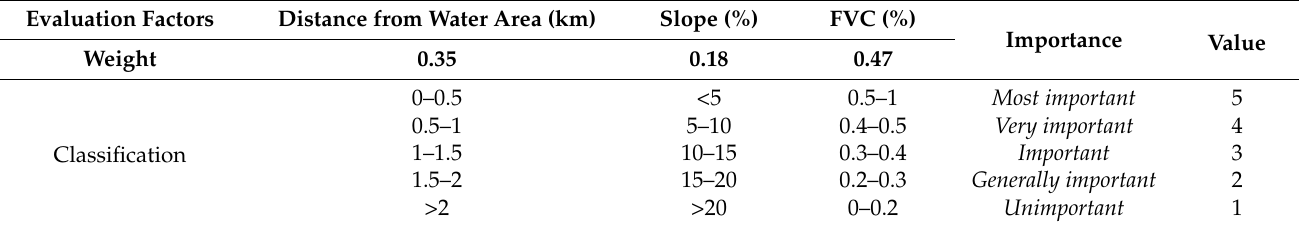
Table 1. Evaluation system for the function of water